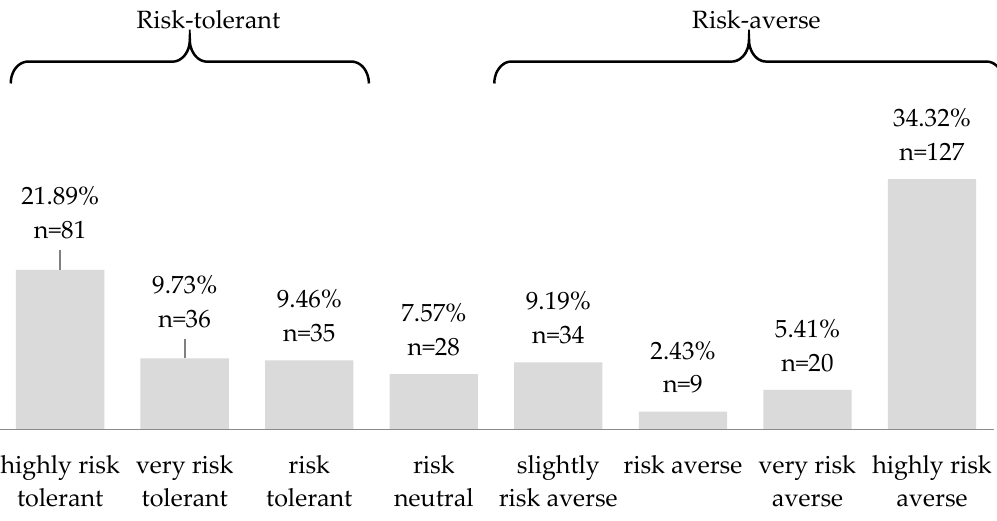
Figure 3. Distribution of the farmers according to their risk level. n : numbers.